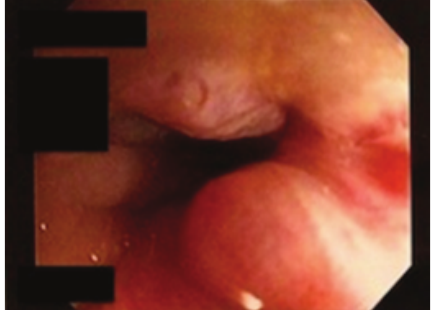
Figure 3: Colonoscopic image demonstrating the opening of the anorectal malformation. A small hemorrhoid is noted at the 5:00 position.